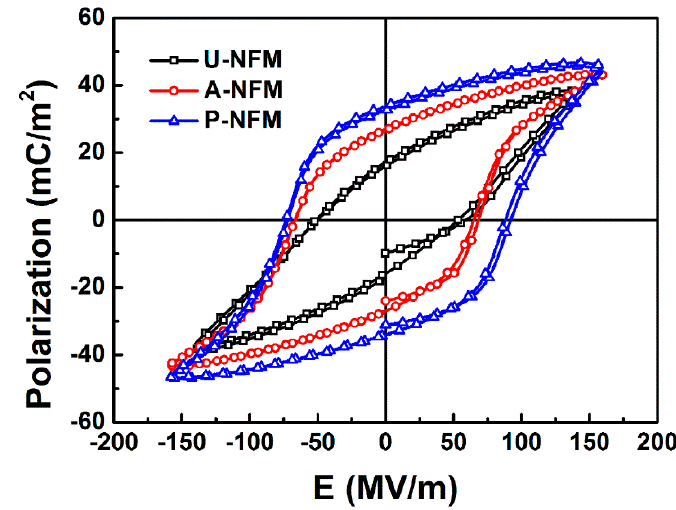
Figure 3. The P-E hysteresis loops of P(VDF-TrFE) NFMs treated with different postprocessing at a polarization electric field of 160 MV/m.